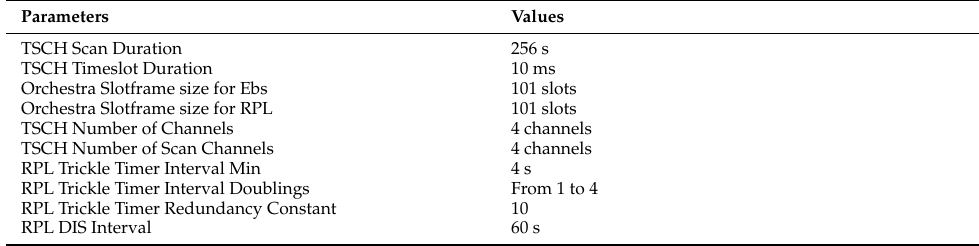
Table 4. Protocol stack